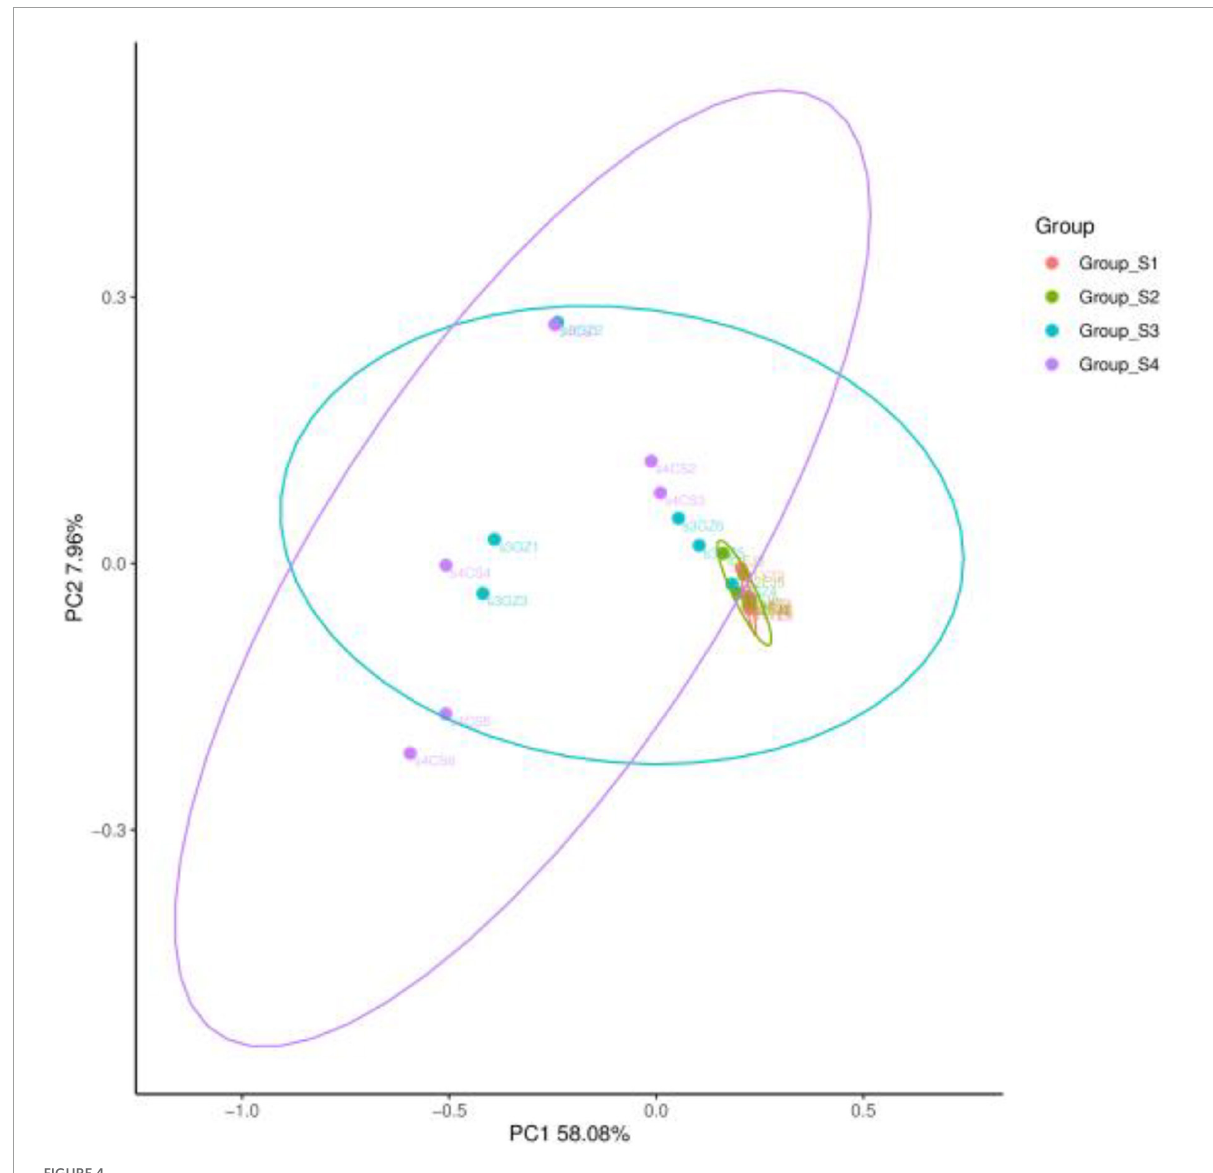
FIGURE4 Principal coordinates analysis (PCoA) results of bacterial communities of fermented mutton sausage during natural ripening based on Bray–Curtis distance with 95% confidence